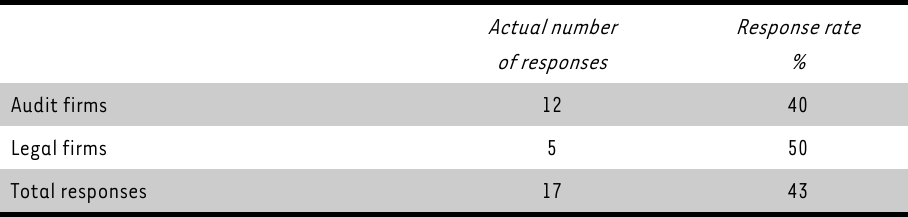
Actual number of